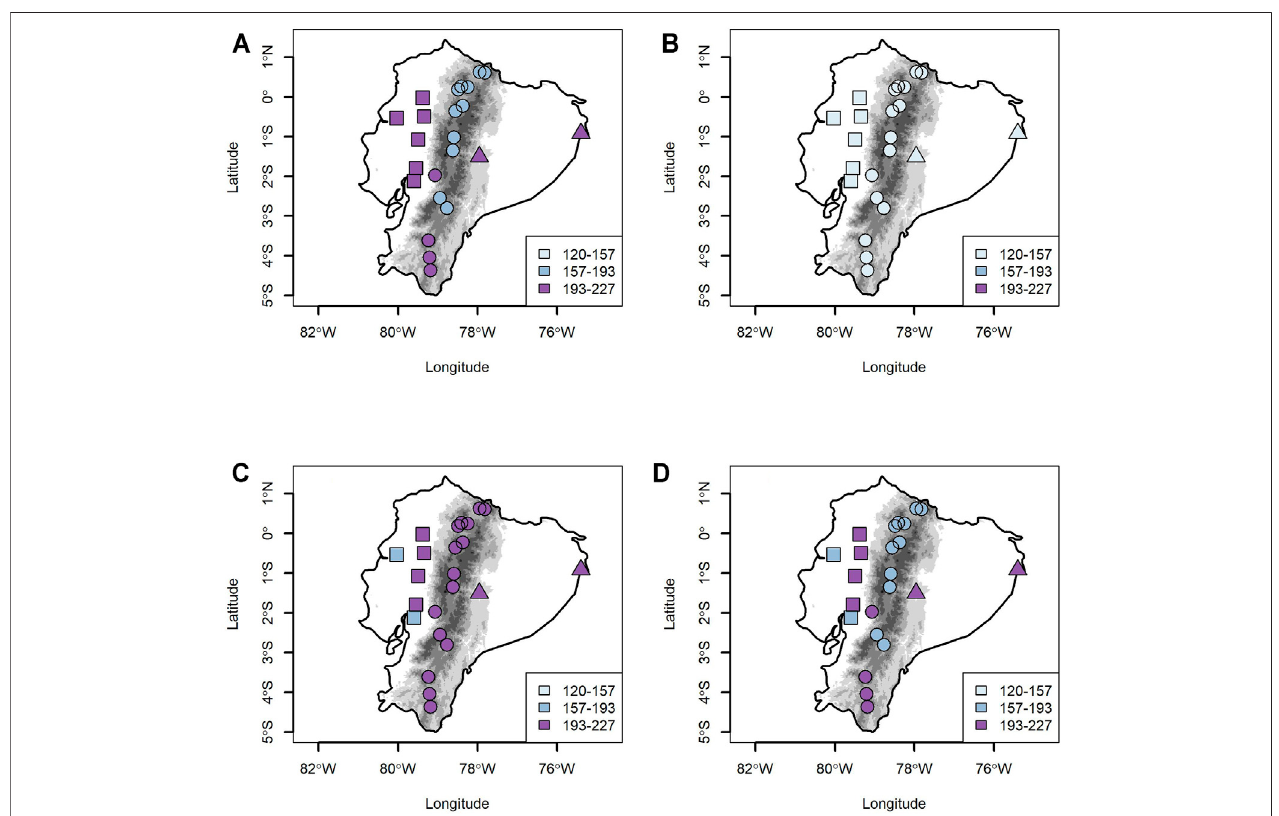
FIGURE 7 | HRD mean value for the period 2041 – 2070 from CSIRO (A) , GISS (B) , and IPSL (C) . Figure 7D is the ensemble that explains the median from three WGCMs.